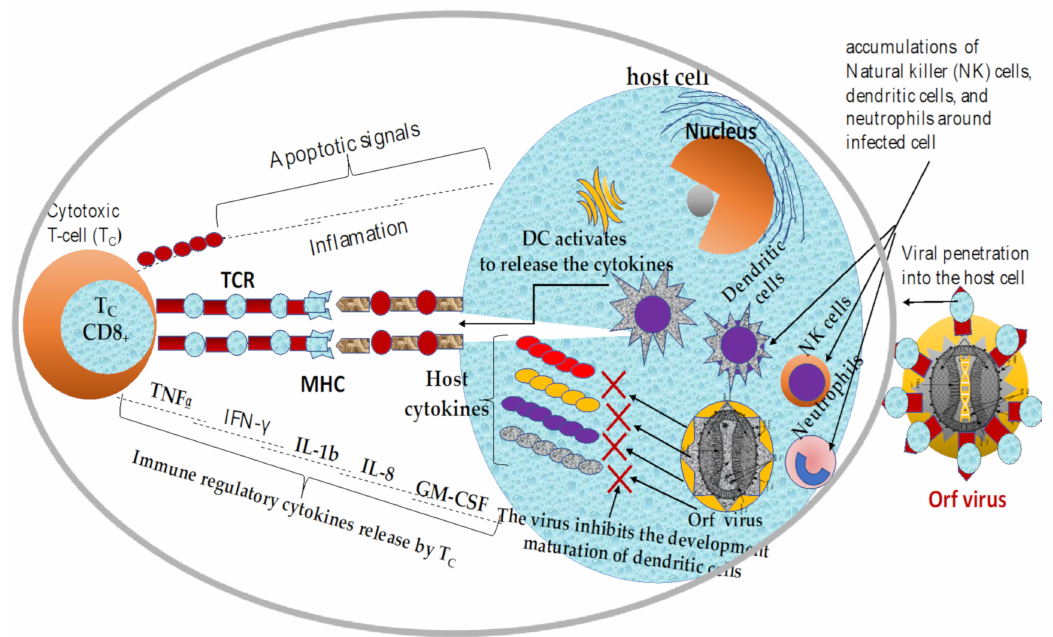
Figure 2. Orf virus invades a susceptible host and temporarily replicates in infected cells by subverting the reactivation of the immune response [102]. Once internalized, innate immune cells such as neutrophils, dendritic cells (DCs), [103] and natural killer cells (NKs) are constantly recruited to sites of infection to engulf the antigens and facilitate migration of the engulfed antigens to peripheral lymph nodes, where antigen presentation to newly recruited naive T cells [105] and memory cells occurs. The DCs present the viral antigen to the specialized cytotoxic CD8 + T cells of the immune system, resulting in the proliferation of granulocyte-macrophage colony-stimulating factor (GM-CSF), interleukin-1 β (IL-1b), interferon- α (IFN- α ), and IL-8 and IFN- γ . The virus can subvert the actions of the host immune response by secreting anti-inflammatory immunomodulatory proteins responsible for neutralizing the virus